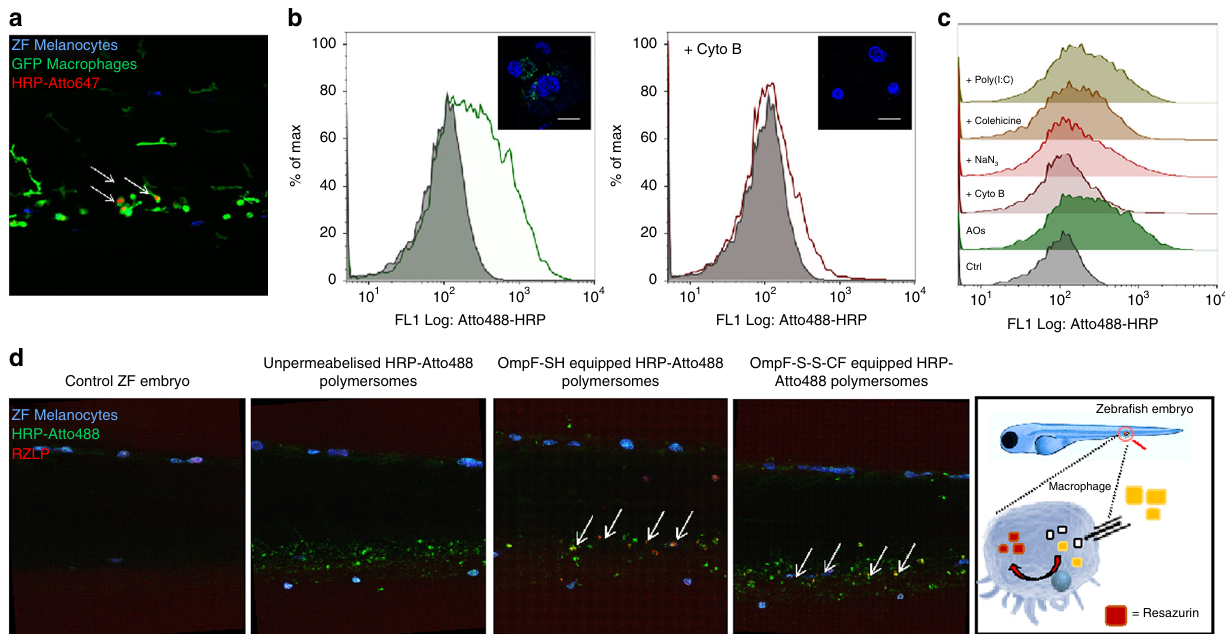
Fig. 5 Internalisation and activity of AOs in macrophages in vitro and in vivo. a Localisation of AOs in ZFE. Lateral view of the ZFE injected with HRP- Atto647-loaded AOs equipped with OmpF-S-S-CF. Arrowheads: Localisation of AOs. Blue signal: ZFE melanocytes. Green signal: GFP macrophages. Red signal: Atto647-loaded AOs. b Phagocytosis of AOs by human macrophage differentiated THP-1 cells in vitro. Qualitative (inset) and quantitative analysis of macrophage differentiated THP-1 cells incubated with AOs loaded with Atto488-labelled HRP without addition of inhibitors (left), and in the presence of phagocytosis inhibitor cytochalasin B (Cyto B) (right). Blue signal: Hoechst 33342 nucleus stain. Green signal: Atto488 HRP. Scale bar inset 20 µ m. c Quanti fi cation of AOs in the presence of different pharmacological pathway inhibitors by fl ow cytometry: polyinosinic acid (Poly(I: C)), colchicines, cytochalasin B (Cyto B) and sodium azide (NaN 3 ). d In vivo ZFE biodistribution and activity of AOs — lateral view of the ZFE cross- section. Blue signal: ZFE melanocytes. Green signal: HRP-Atto488. Red signal: Resazurin-like product (RZLP). Arrows show regions of enzymatic activity of